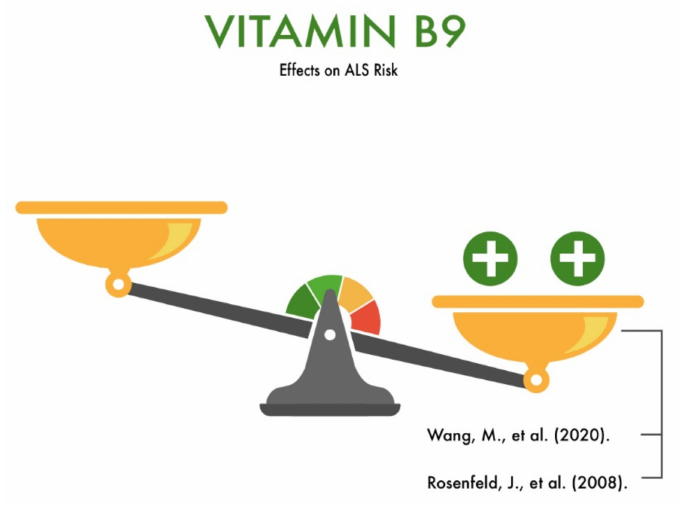
Figure 6. The effect of vitamin B9 on the risk of developing amyotrophic lateral sclerosis